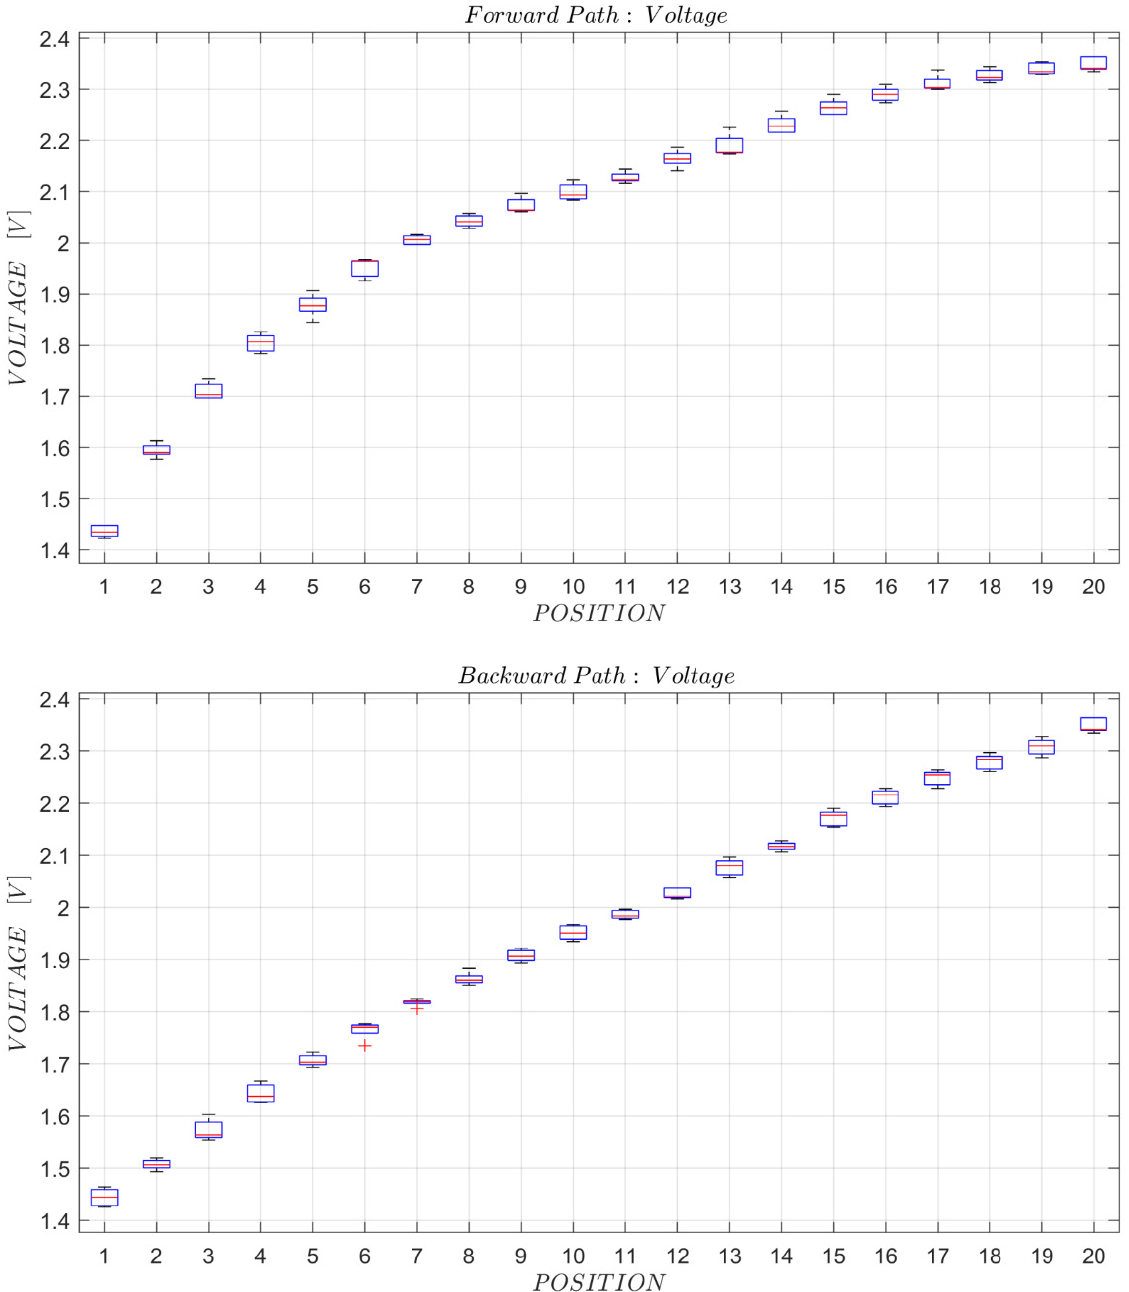
Figure 25. Reference lines for the sensor 001 19 22